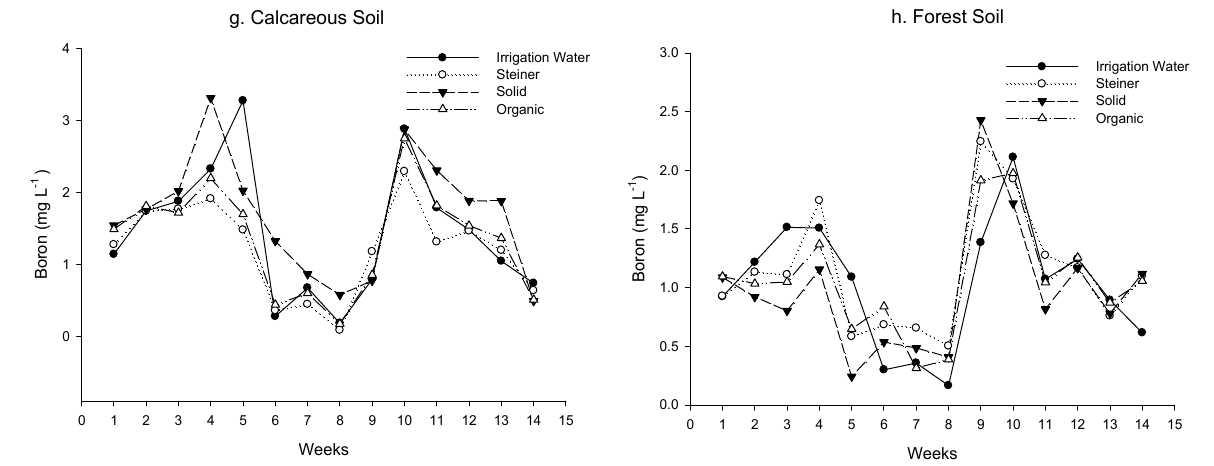
Figure 6. Dynamics of the oxide reduction potential (ORP), total nitrogen, magnesium, and boron, determined in soil solution samples for a calcareous and forest soil, under pot and greenhouse conditions, submitted to different contribution scenarios of nutrients, through inorganic fertilizers: nutrient solution (Steiner) and fertilizers in fractional form (solid) and organic fertilizer with vermicompost tea (aqueous extract).